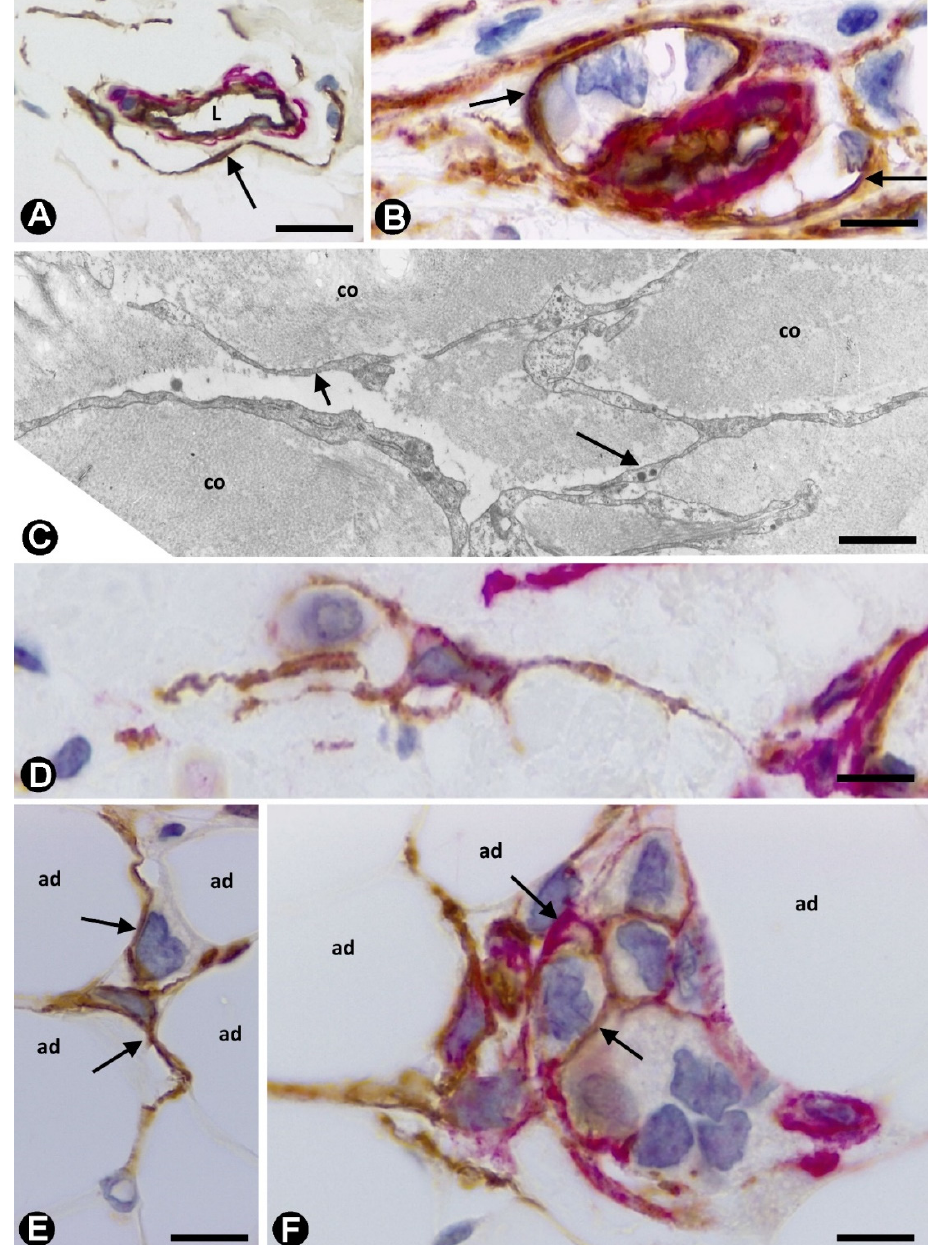
Figure 7. ( A , B , D – F ): Double immunochemistry staining for CD34 (brown) and α SMA (red). Hae- matoxylin counterstain. ( C ): Ultrathin section. Uranyl acetate and Lead citrate. ( A ): One CD34+SC/TC (arrow) around a small vessel. ( B ): Stromal cell processes (arrows) are observed surrounding neoplastic cells around a small vessel. ( C ): Ultrastructural image of telocyte telopodes (arrows) between collagen (CO) components in the interlobular connective tissue. ( D ): One CD34+ stromal cell with long processes, one of which surrounds a neoplastic cell. ( E ): CD34+SCs/TCs (arrows) between adipocytes (ad). ( F ): CD34+ (brown) and α SMA+ (red) stromal cells (arrows) are seen around a nest of neoplastic cells between adipocytes (ad). Bar: ( A ): 30 µm; ( B , F ): 20 µm; ( C ): 4 µm; ( D , E ): 15 µm.